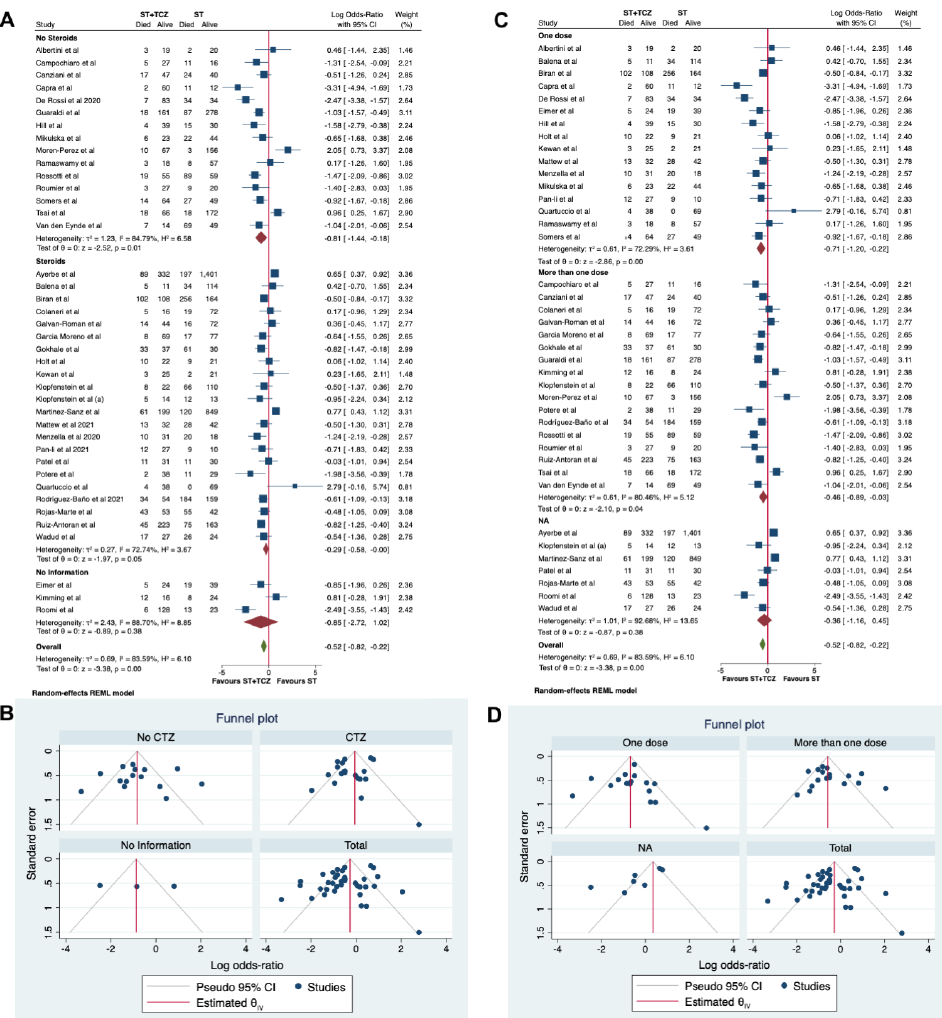
Figure 7. ( A ) Forest plot and ( B ) funnel plot of the subgroup analysis on the observational studies stratified by use of steroids. ( C ) Forest plot and ( D ) funnel plot of the subgroup analysis on the observational studies stratified by number of TCZ dose received.